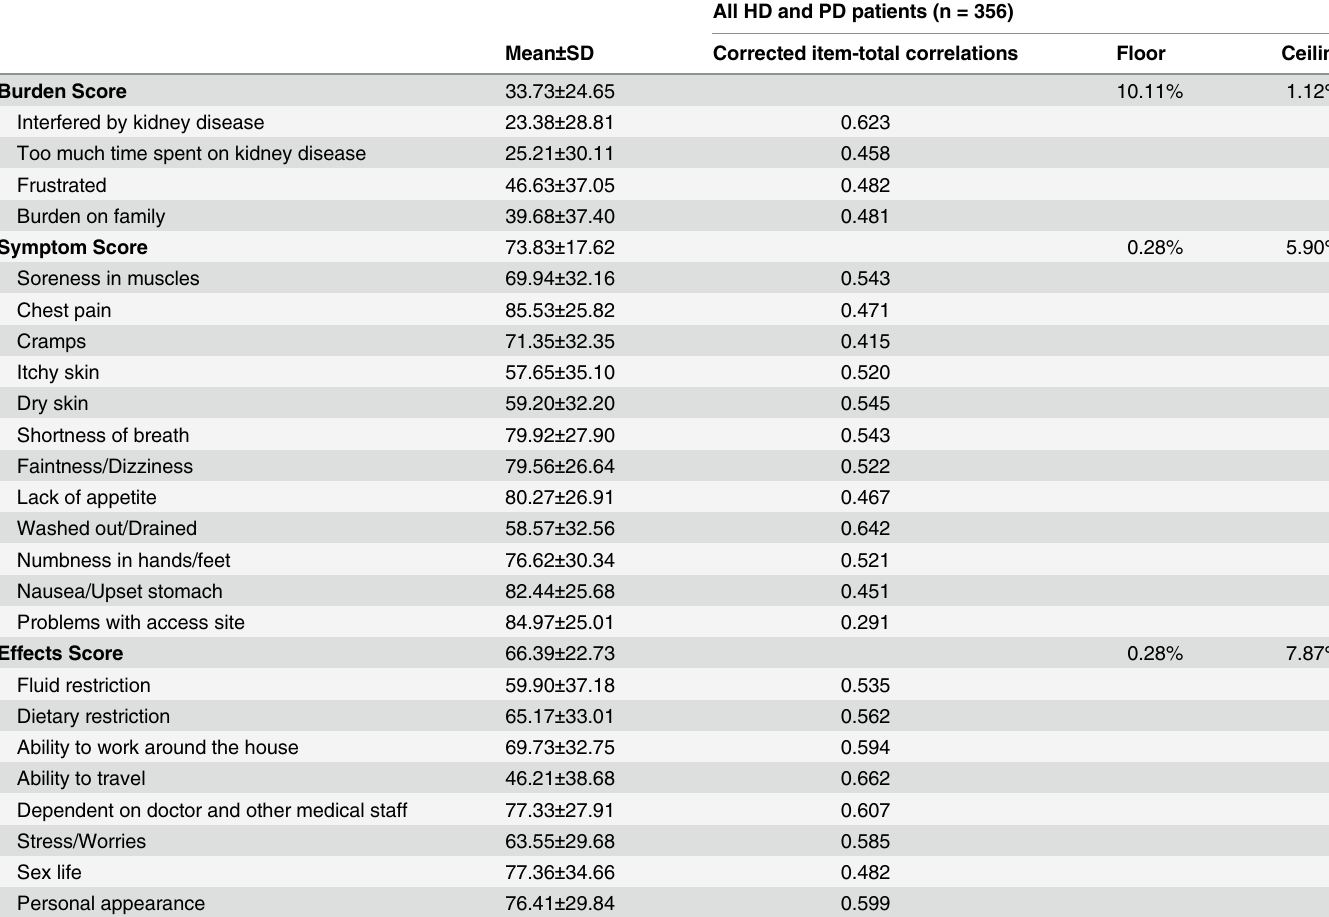
Table 3. Descriptive, ceiling and floor effects of disease-specific domains of